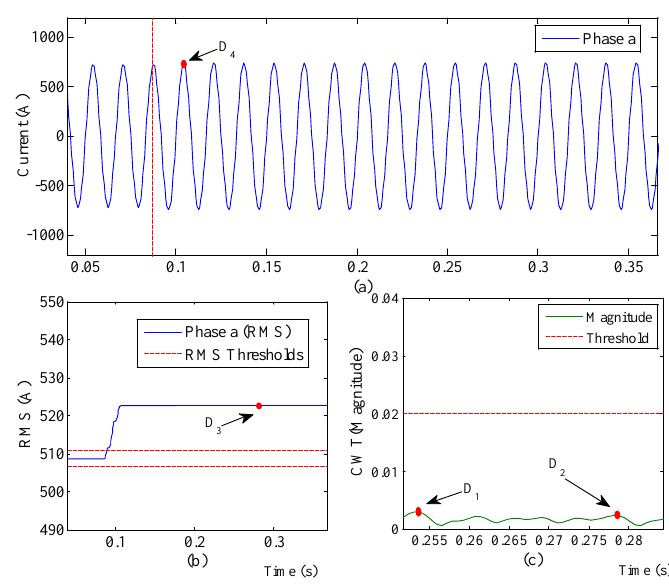
and ; ( b ) ; ( c ) and 𝐼𝐼 𝑎𝑎 𝐷𝐷 4 𝐷𝐷 3 𝐷𝐷 1